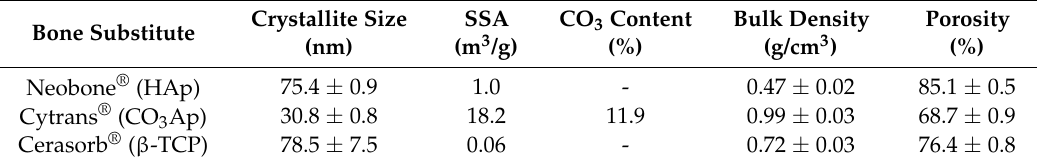
Table 1. Physical properties of Neobone ® (HAp), Cytrans ® (CO 3 Ap), and Cerasorb ® ( β -TCP).